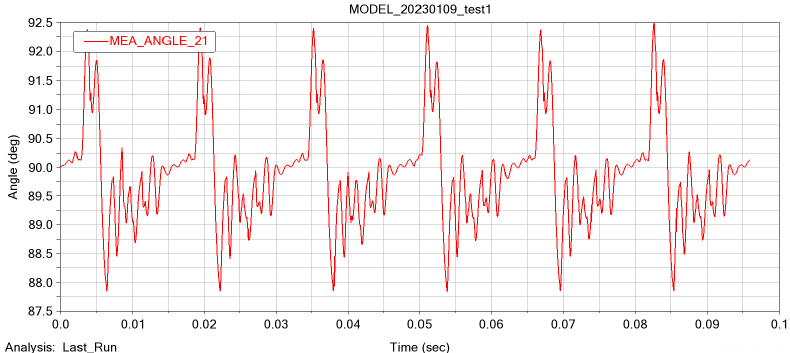
Figure 28. Torsional vibration of the fi rst crank.